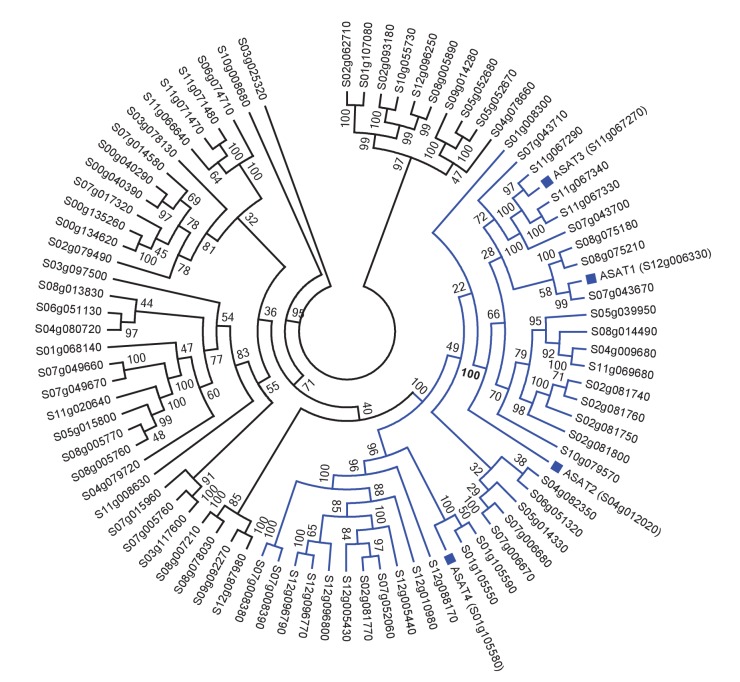
Tomato ASATs are members of the BAHD enzyme family.(A) SlASATs shown in a phylogenetic tree with all other BAHDs in cultivated tomato genome. The ‘Solyc’ in the gene names has been shortened to ‘S’. BAHD is an acronym for four acyltransferase enzymes: benzyl alcohol O-acetyltransferase (BEAT), anthocyanin O-hydroxycinnamoyltransferase (AHCT), N-hydroxycinnamoyl/benzoyltransferase (HCBT), deacetylvindoline 4-O-acetyltransferase (DAT) - the first discovered members of this family. Please refer to Figure 1 for the biochemical activities of SlASATs. Only sequences > 200 aa in length were used in this analysis. Tree was constructed using Maximum Likelihood with the PROTGAMMAJTT model in RAxML v8.0.6 with 1000 rapid bootstrap replicates specified.